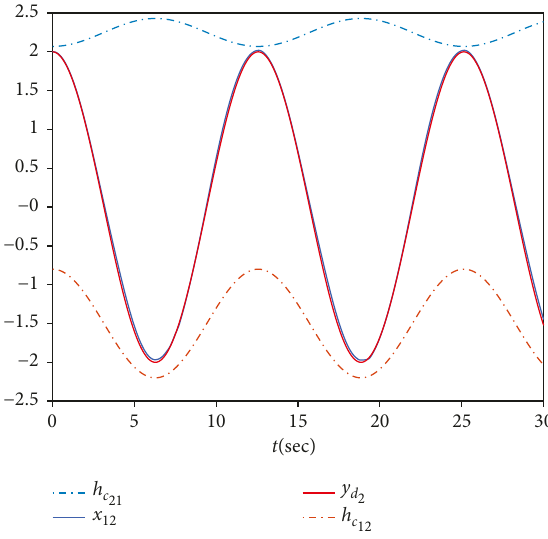
Figure 1: The time response of the output x . reference y d 1